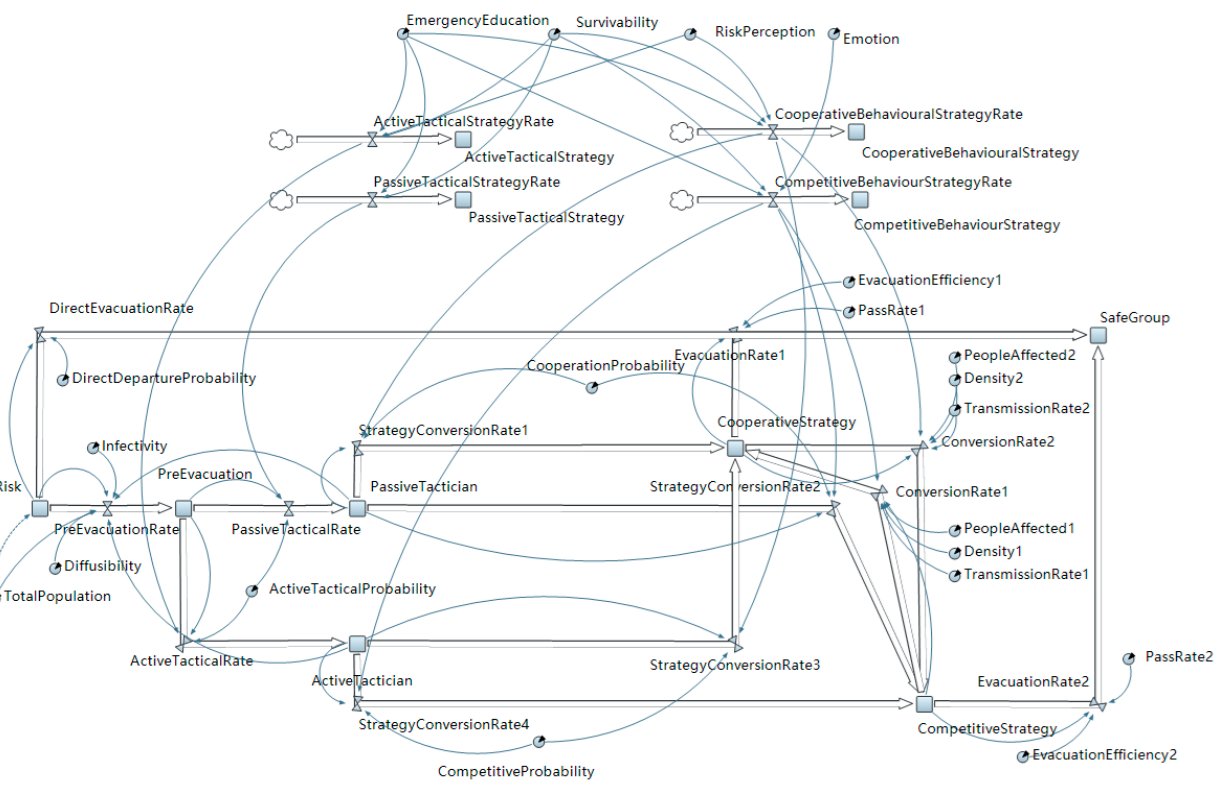
Figure 5. System dynamics model of the evacuation state evolution based on decision capabilities.